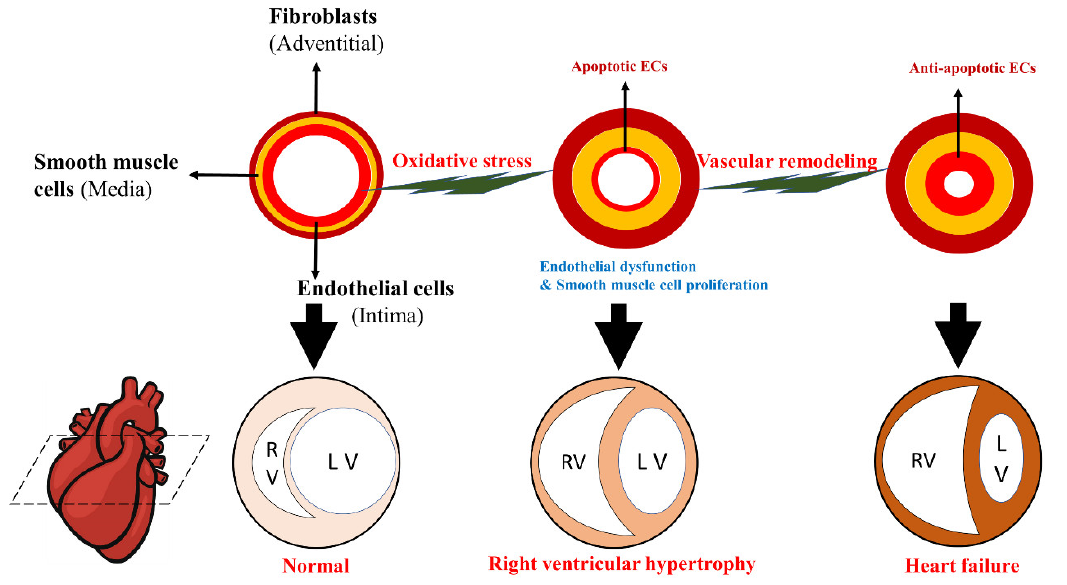
Figure 2. Schematic progression of pulmonary arterial hypertension. Progressive vascular remodeling associated with PA cell proliferation and apoptosis resistance occurs in the distal pulmonary artery after endothelial dysfunction. This structural change gradually results in pulmonary lumen occlusion and increases pulmonary vascular resistance (PVR) and PA pressure. Due to pressure overload, the right ventricle (RV) initially compensates through hypertrophy and increased contractility to maintain cardiac output, gradually leading to heart failure and eventual death.